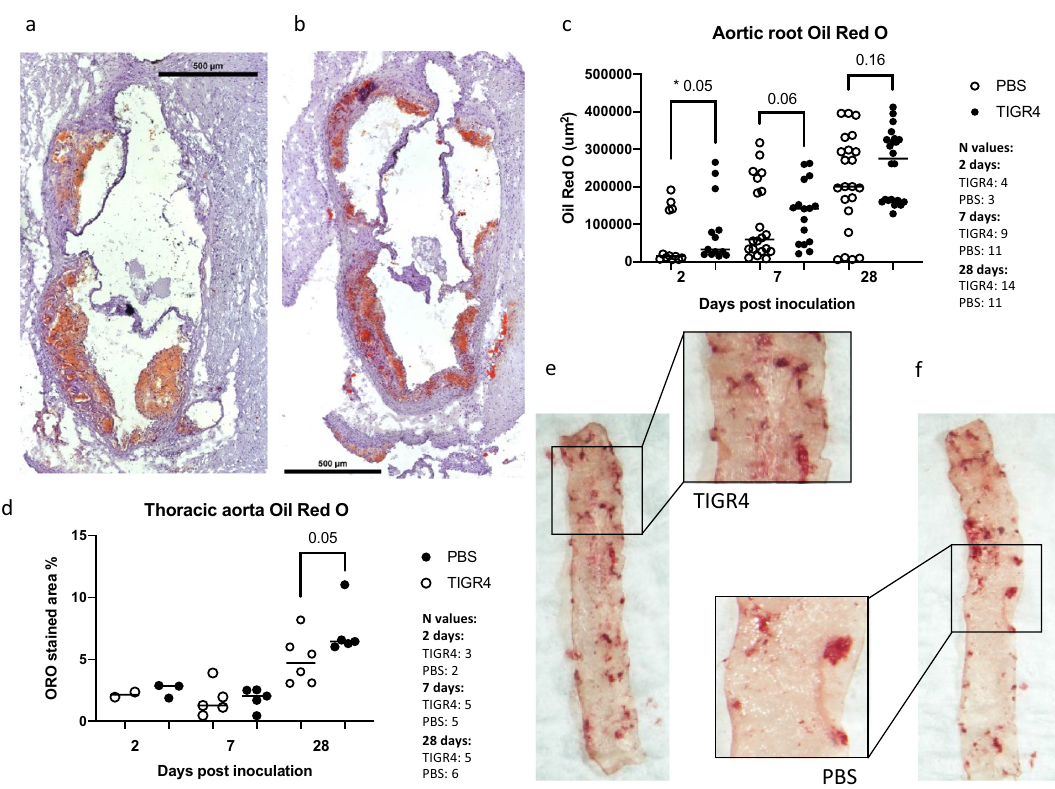
Figure 1. Oil Red O staining of aortic root and thoracic aorta. ( a ) and ( b ) are representative images (taken at 10x) of aortic root from TIGR4- and PBS- inoculated mice at 28-days post-inoculation (PI). ( c ) The area of Oil Red O staining was quantified and compared between groups. Significantly more plaques were observed 2 days post TIGR4 inoculation. ( d ) Quantification of Oil Red O content in thoracic aortas as a percentage of the area of tissue at 2-, 7- and 28- days PI. At 28 days PI, TIGR4 inoculated mice present with significantly more plaque in the thoracic aorta compared to PBS control. ( e ) and ( f ) are representative images of thoracic aorta from TIGR4- and PBS-inoculated mice,